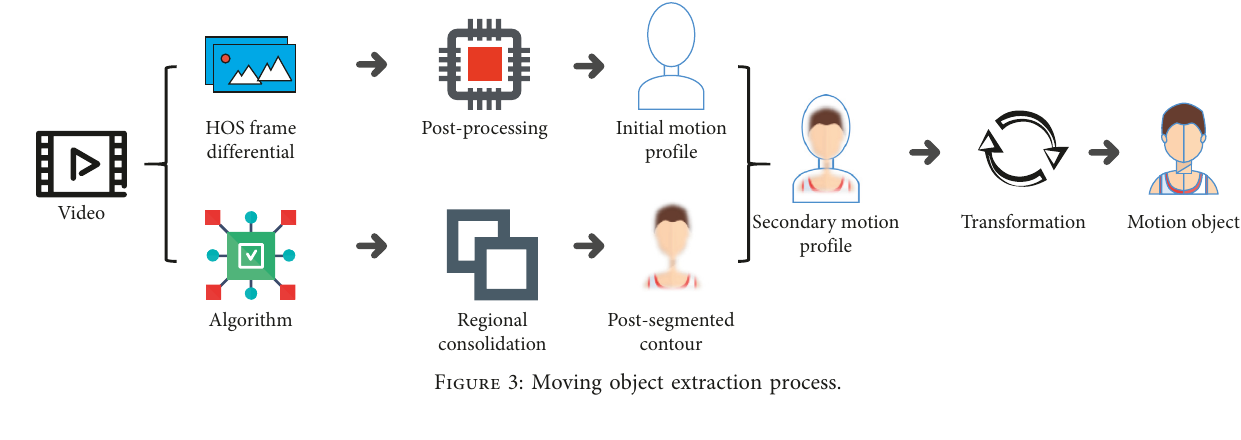
Figure 3: Moving object extraction